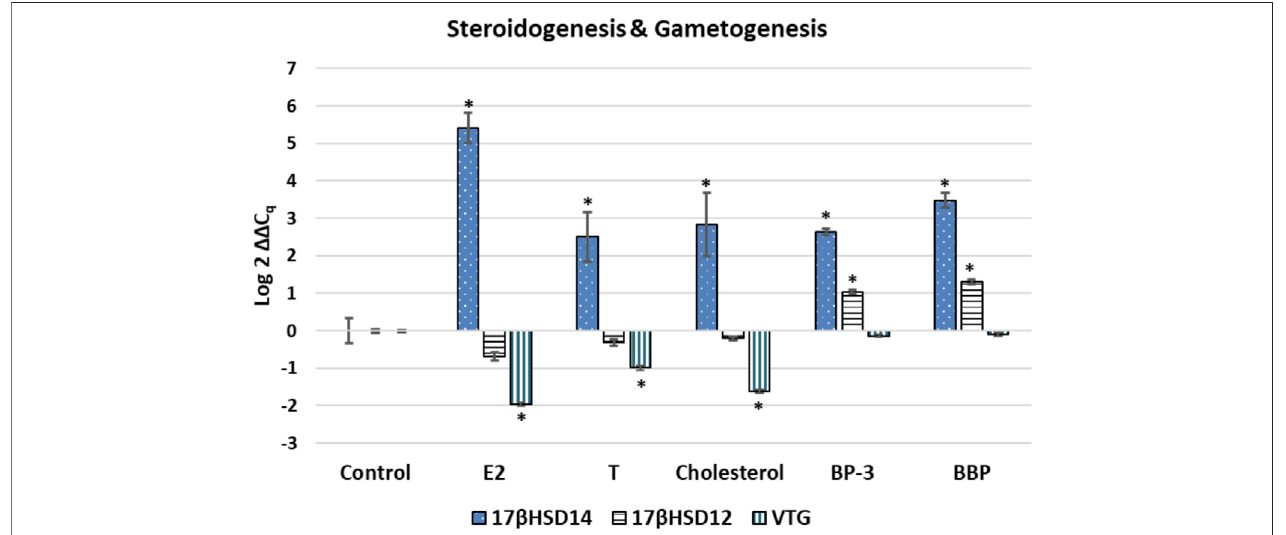
FIGURE1| Expressionpro fi lefortranscriptsassociatedwithsexhormonesteroidogenesisorgametogenesis.The ΔΔ Cqvaluesrepresenttransformedexpression ofaGOIrelativetoRPL11expression.An*representsatreatmentthatwassigni fi cantlydifferent( p < 0.01)relativetothecontrolcondition.Errorbarsrepresent ± SE.E2: estradiol; T: testosterone; BP-3: oxybenzone; BBP: benzyl butyl phthalate; l7§HSD14: 17a-hydroxysteroid dehydrogenase type 14; 17bHSD12: 17b-hydroxysteroid dehydrogenase type 12: VTG: Vitellogenin